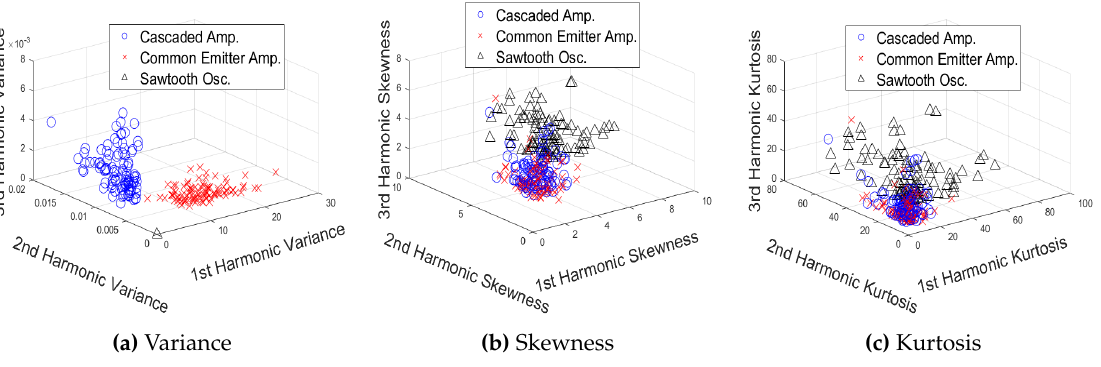
Version June 4, 2022 submitted to Remote Sens. Figure 6. Scattered plots of variance, skewness and kurtosis data in 3D harmonic space, SNR=2 dB. Figure 6. Scatter plots of variance, skewness, and kurtosis data in 3D harmonic space, SNR = 2 dB. 233